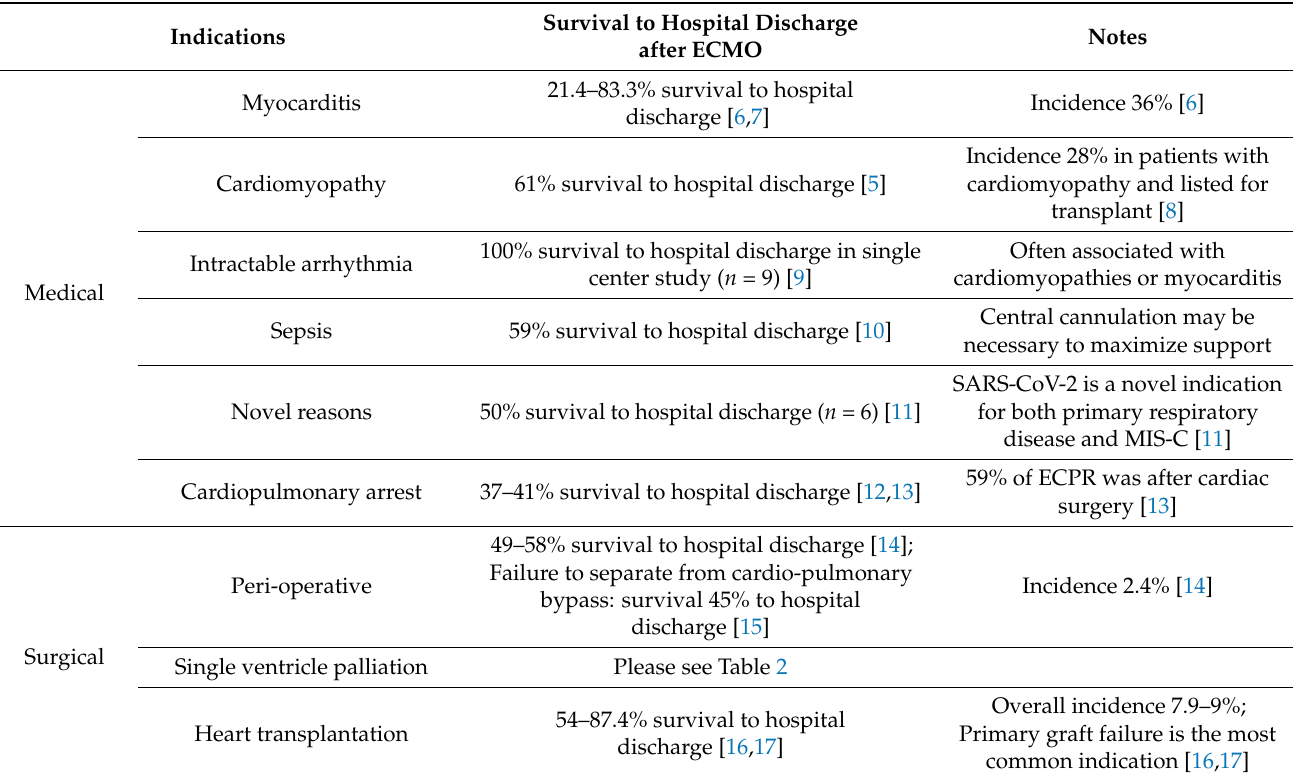
Table 1. Summary of Medical and Surgical Indications and Outcomes for VA ECMO